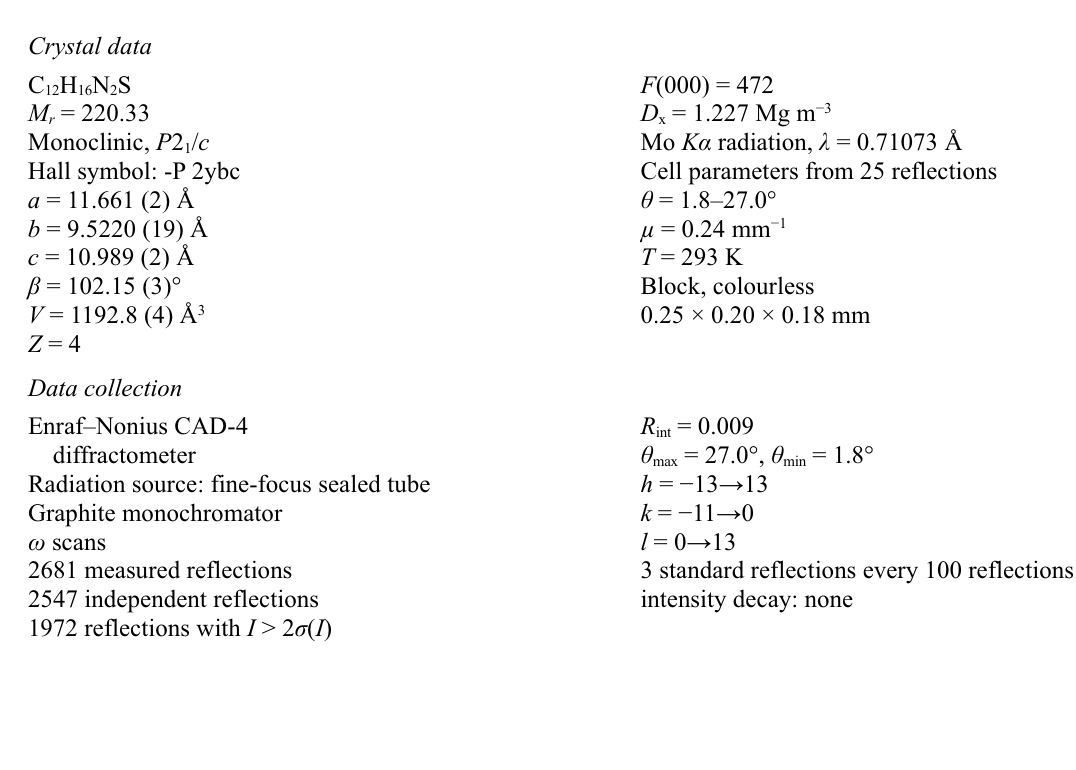
A view of the intermolecular N—H···S hydrogen bonds between the neighbour molecules in the unit cell. N